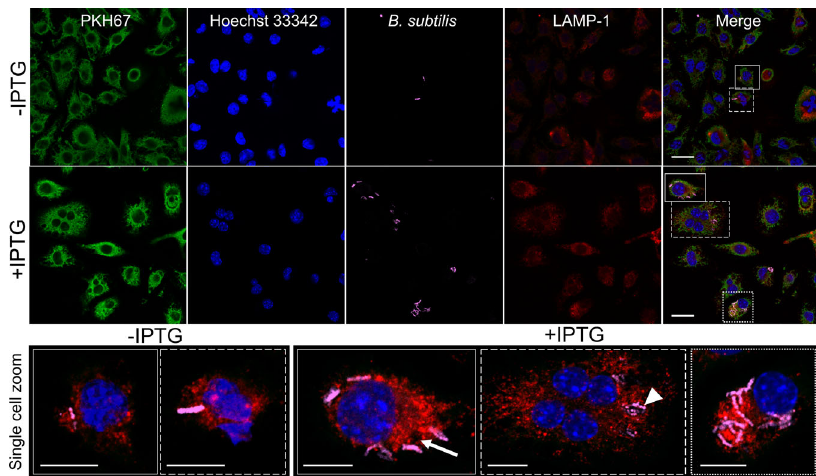
Fig. 2 Confocal imaging identi fi es LLO strain phagosomal escape into the cytoplasm of J774A.1 cells. Confocal imaging was used to identify the PKH67 membrane stain (green; J774A.1 cells), nuclear Hoechst 33342 (blue), B. subtilis (magenta) and LAMP-1 (red). The LLO strain was introduced to J774A.1 cells at a multiplicity of infection (MOI) of 25:1 and treated without (-IPTG) or with IPTG ( + IPTG). Examples of single cells are displayed as zoomed regions with Hoechst 33342, B. subtilis and LAMP-1 channels merged (below). Without IPTG, there were few B. subtilis positive regions (dashed line), mostly consisting of punctate regions of signal (solid line). When LLO was induced with IPTG ( + IPTG), there was evidence of B. subtilis LLO escape. Empty LAMP-1 structures could be identi fi ed (solid line, white arrow) with adjacent B. subtilis LLO. There were also B. subtilis LLO which had not yet escaped the phagosome (dashed line, white arrowhead) but the majority of identi fi ed B. subtilis LLO were within the cytoplasm of the cells (dotted line). The z-depth was chosen for each zoomed image and each channel was adjusted to provide a representative image of each scenario. Scale bars = 20 µ m (upper); scale bars = 10 µ m